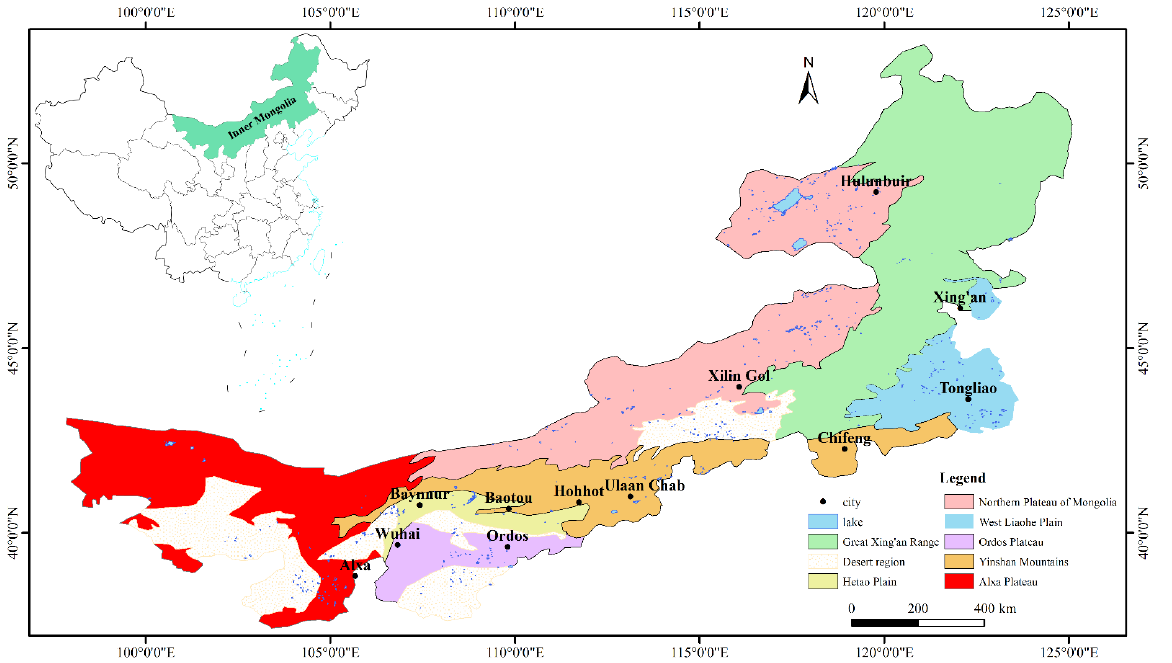
Figure 1. Distribution of lakes in the different geomorphological units in Inner Mongolia. As for the temporal variations in the number of lakes within the different geomorphic units (Table 3), during 1990 – 2018, the number of lakes with individual areas of >1 km 2 decreased in the northern Inner Mongolian Plateau region, the desert zone, the West Liaohe Plain, the Yinshan Mountains, and the Daxinganling Mountains. Among these re- gions, the number of lakes in the West Liaohe Plain experienced the most significant de- crease of 79 to 36 (54.43%), followed by that on the northern Inner Mongolian Plateau, which declined from 149 to 117 (21.47%). The temporal trend associated with the number of lakes within the desert zone consisted of two stages. Stage 1 involved an annually in- creasing trend during 1990 – 2000, with an overall increase of eight in the entire desert re-